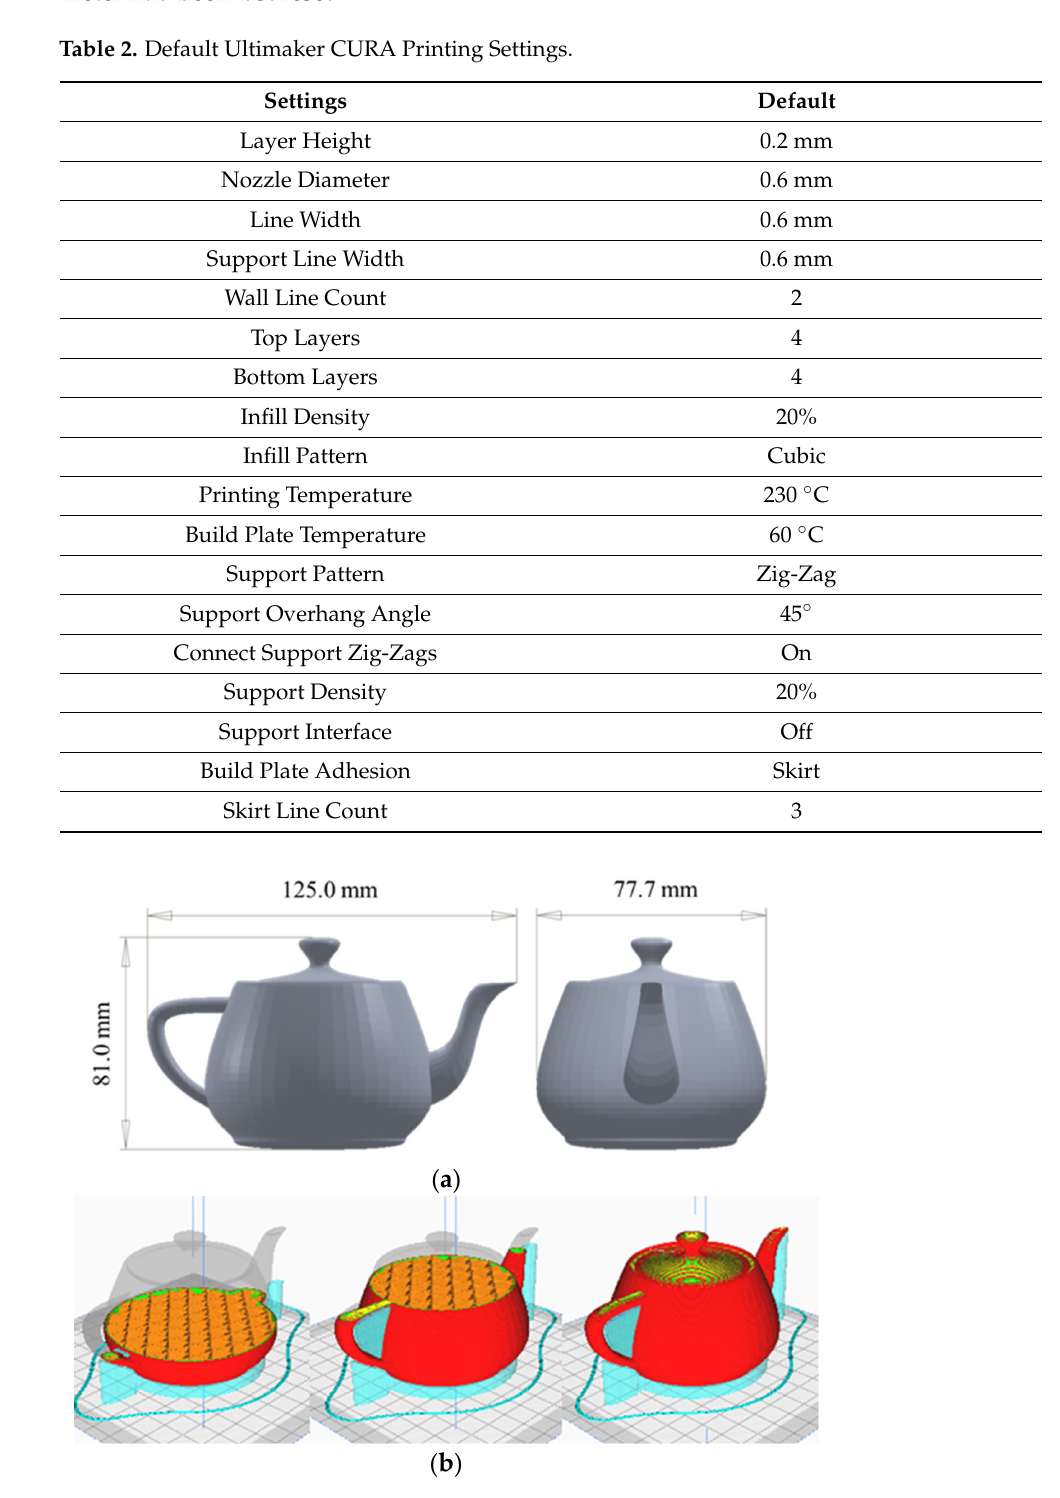
Figure 1. ( a ) Teapot model ( b ) Unmodified g ‐ code (20% Cubic infill, 0.6 mm Support Width, Black colorFabb Economy